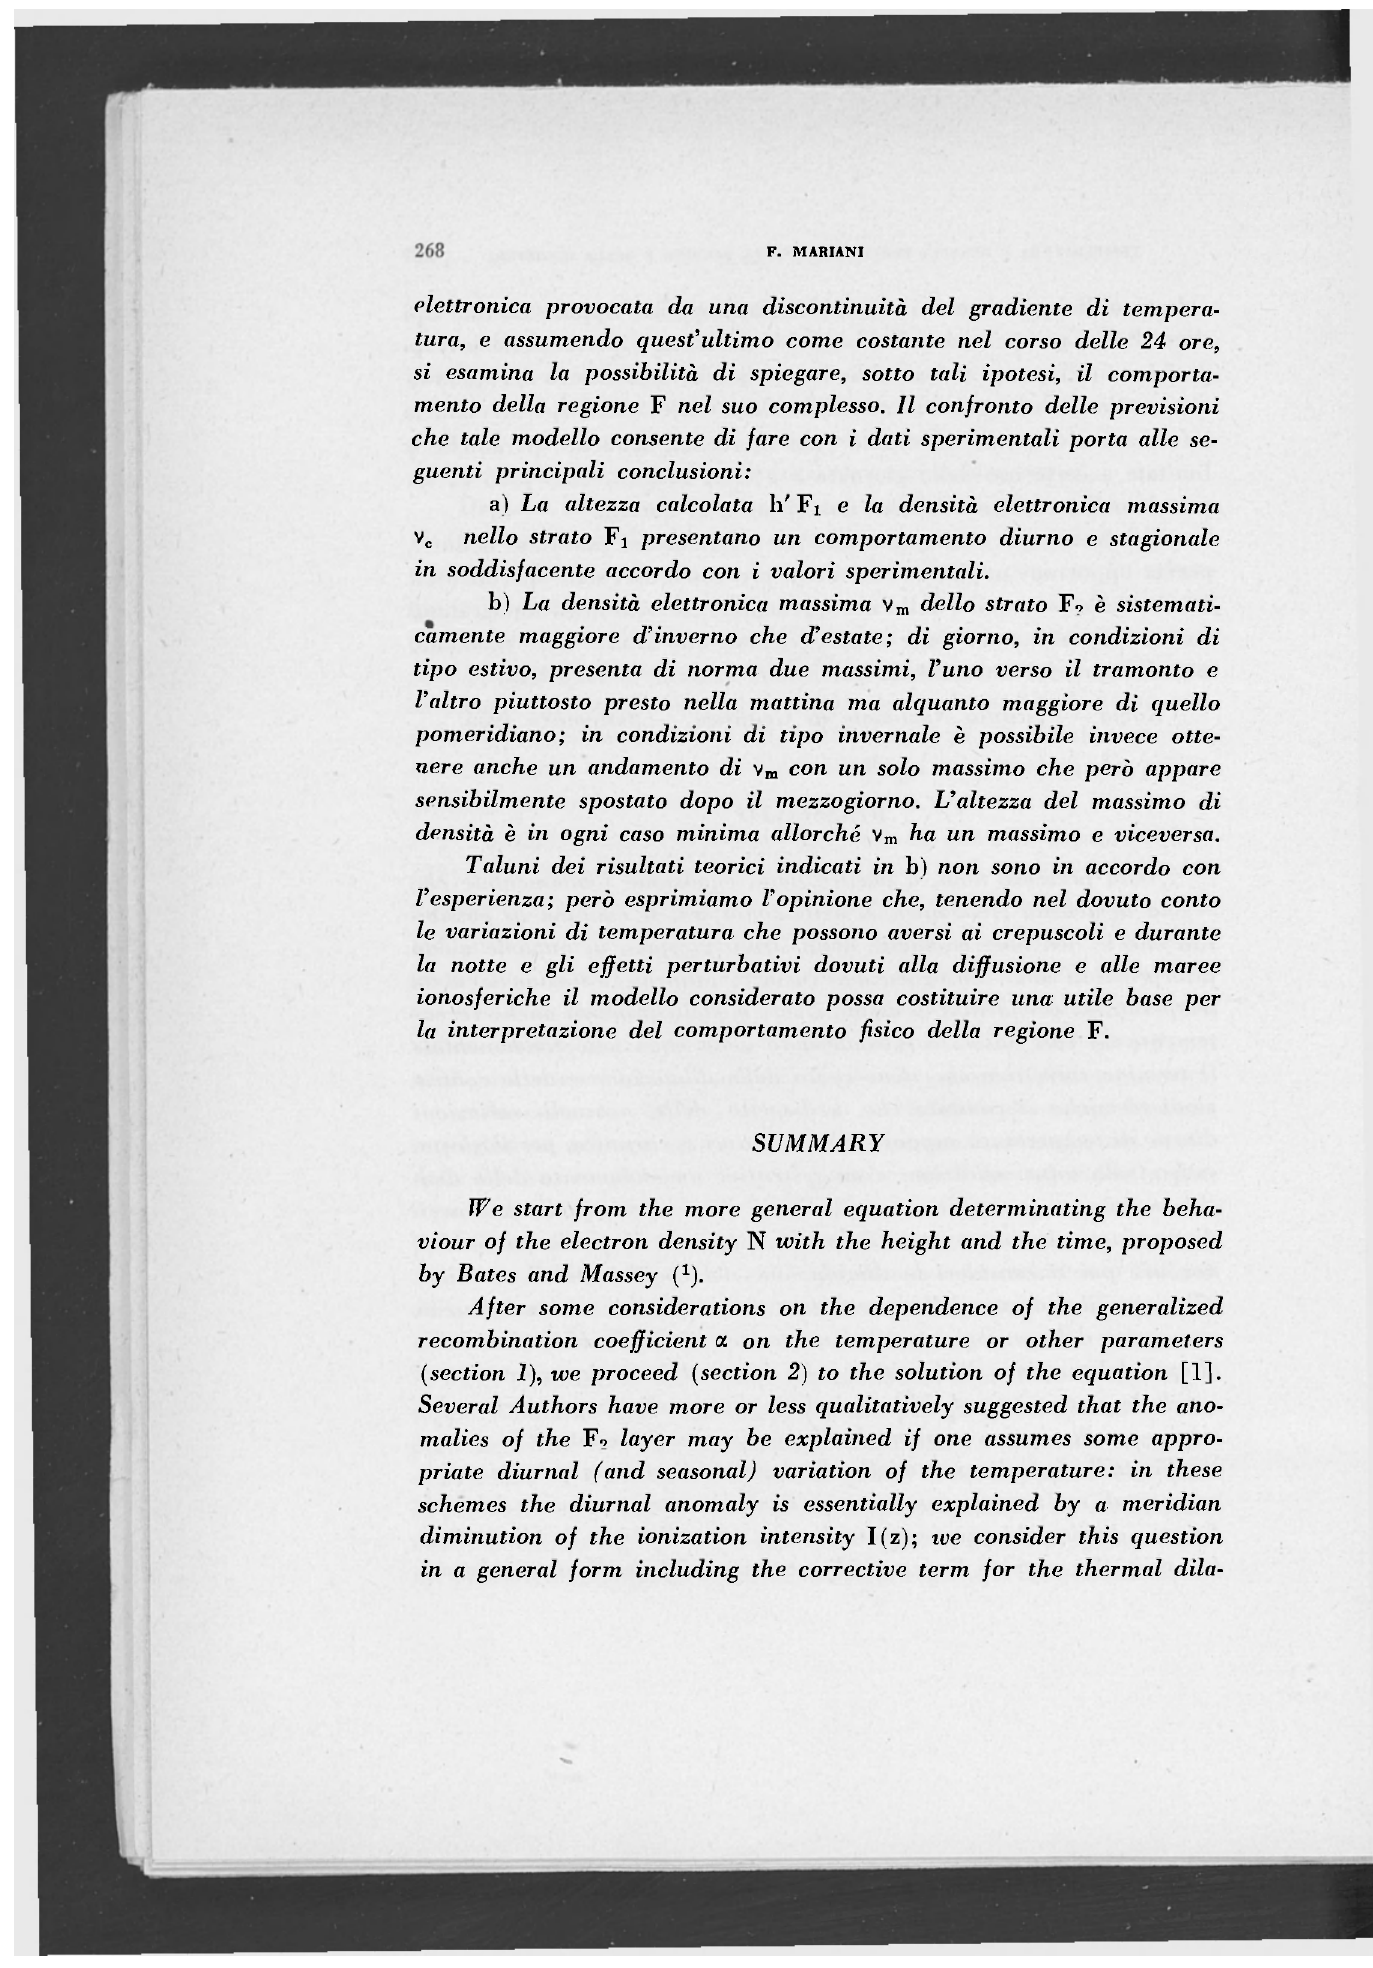
more or less qualitatively suggested that the ano- malies of the Fo layer may be explained if one assumes some appro- priate diurnal (and seasonal) variation of the temperature: in these schemes the diurnal anomaly is essentially explained by a meridian diminution of the ionization intensity I(z); ice consider this question in a general forni including the corrective term for the tliermal